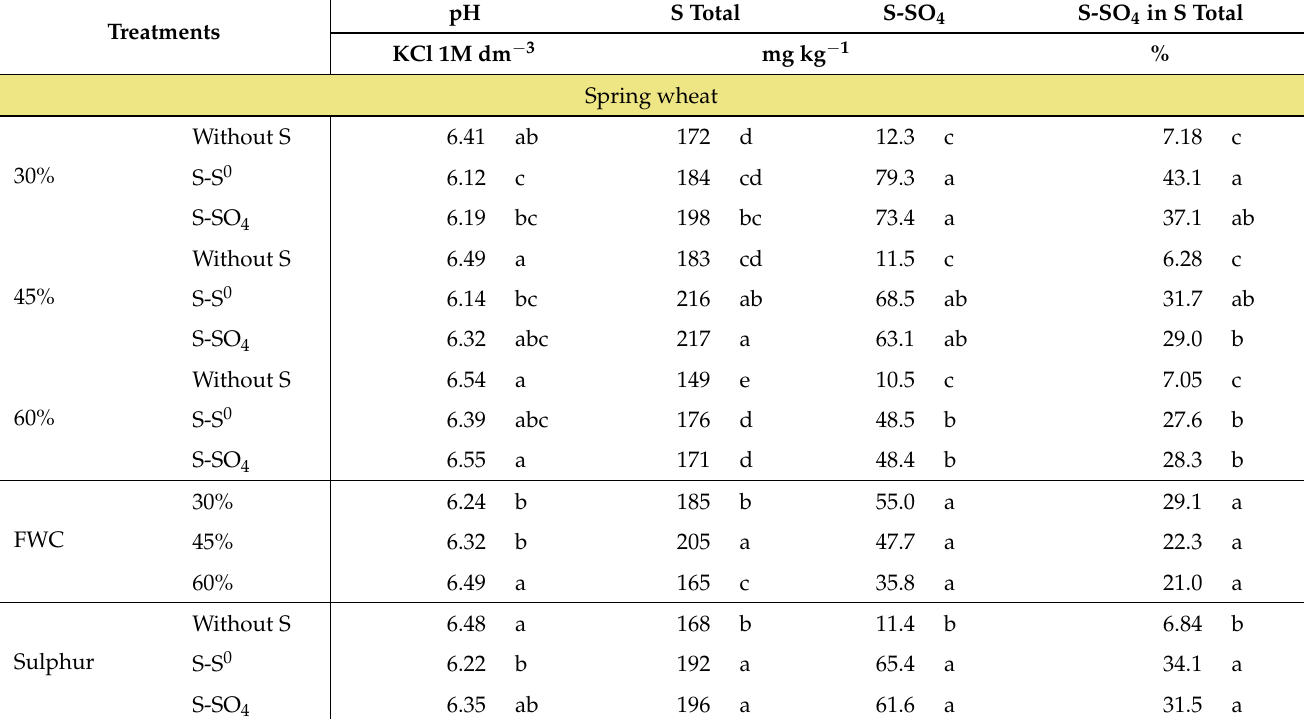
Table 8. Soil pH and the content of S total, sulphates (VI). Values indicated by the same letter are not significantly different ( α = 0.05). pH S Total S-SO